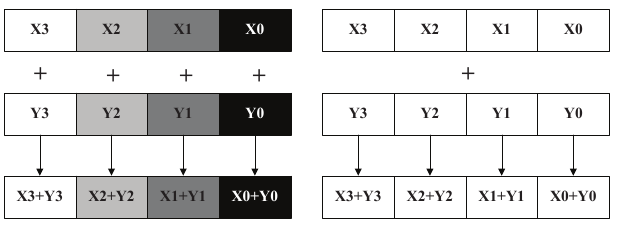
Figure 3. The operating model of SISD ( Left ) and SIMD ( Right ).